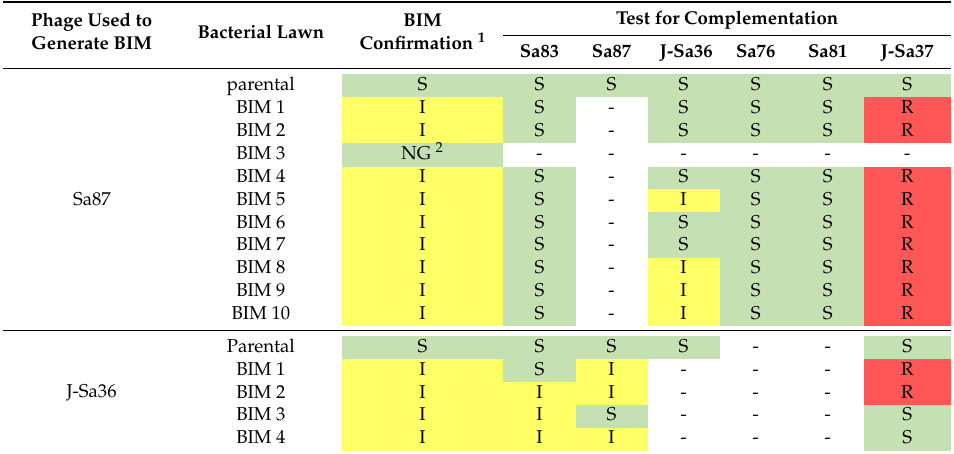
Table 3. Complementation among candidate